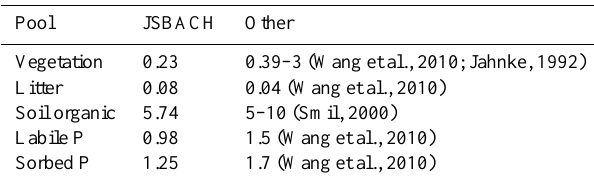
Table 5. Simulated P stocks (Gt ( P ) ) from the simulation CNP com- pared with published estimates. The simulated stock sizes are means of the years 1970–1999. The litter pool contains leaf litter and fast decomposing soil organic